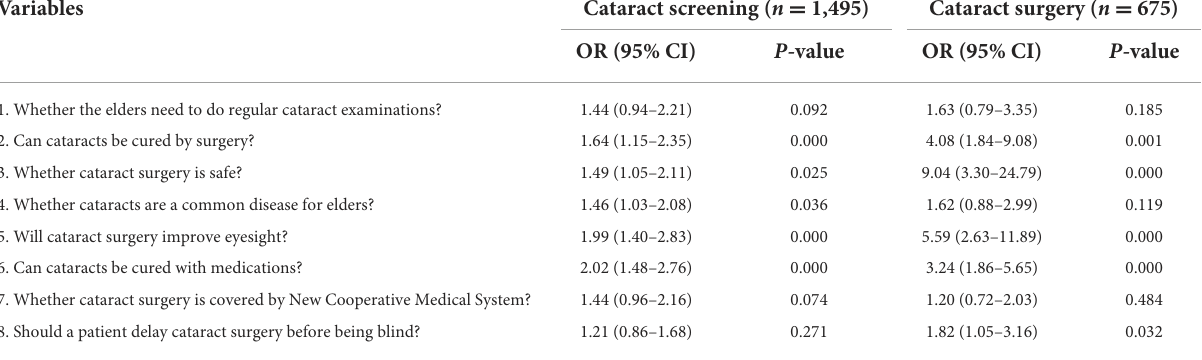
TABLE 5 Multivariate estimation of the association of knowledge about cataracts with eye care utilization a .